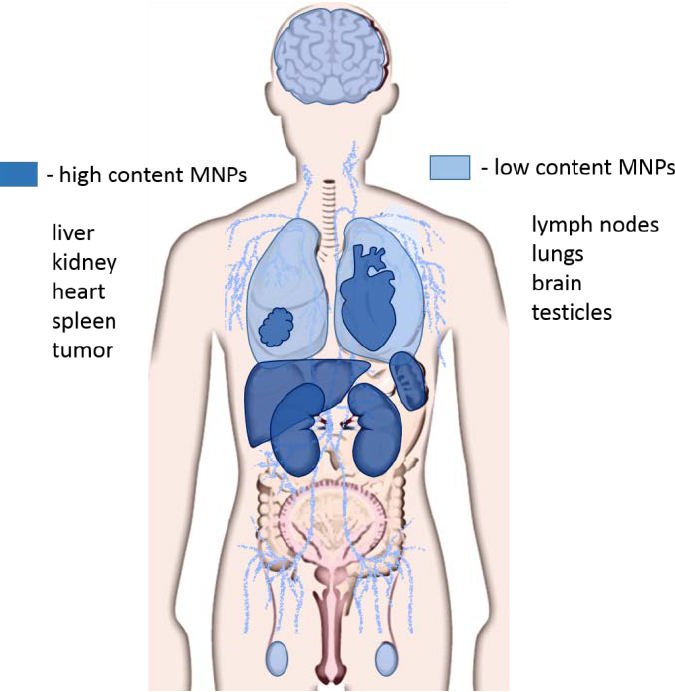
Figure 3. Distribution of magnetic nanoparticles in organs and tissues. The high concentration of magnetic nanoparticles (MNPs) accumulates in the liver, kidneys, spleen, heart, and tumors. Lower concentrations of MNPs are observed in the brain, lungs, lymph nodes, and testes. Table 1. The distribution of MNPs in organs and tissues, depending on their size.